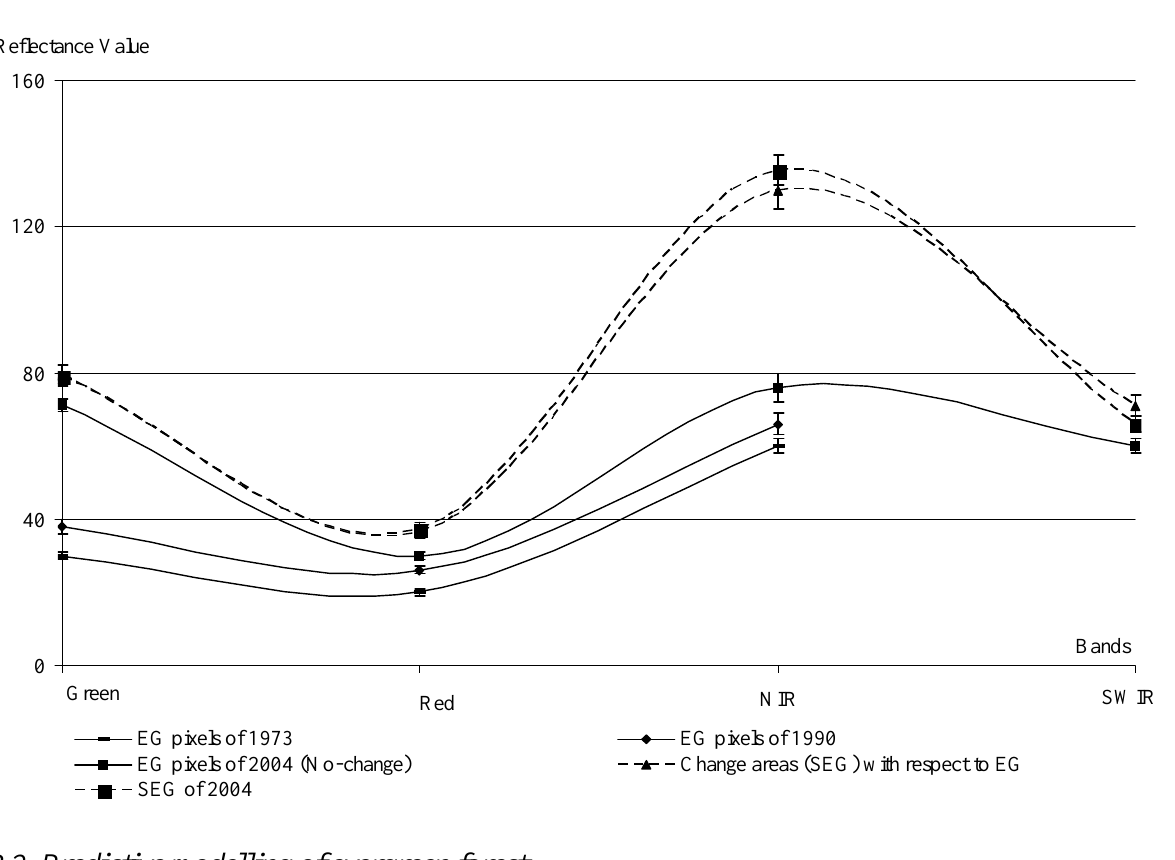
Figure 3. Spectral properties (X-axis has spectral bands and Y-axis has reflectance value) differentiating evergreen and semi-evergreen forest types of KMTR, South Western Ghats of Tamil Nadu,